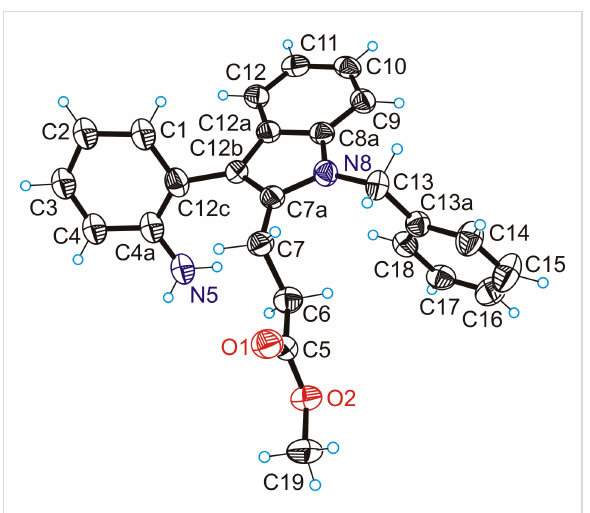
Figure 2: ORTEP view of 1a with thermal ellipsoids drawn at the 50% probability level.